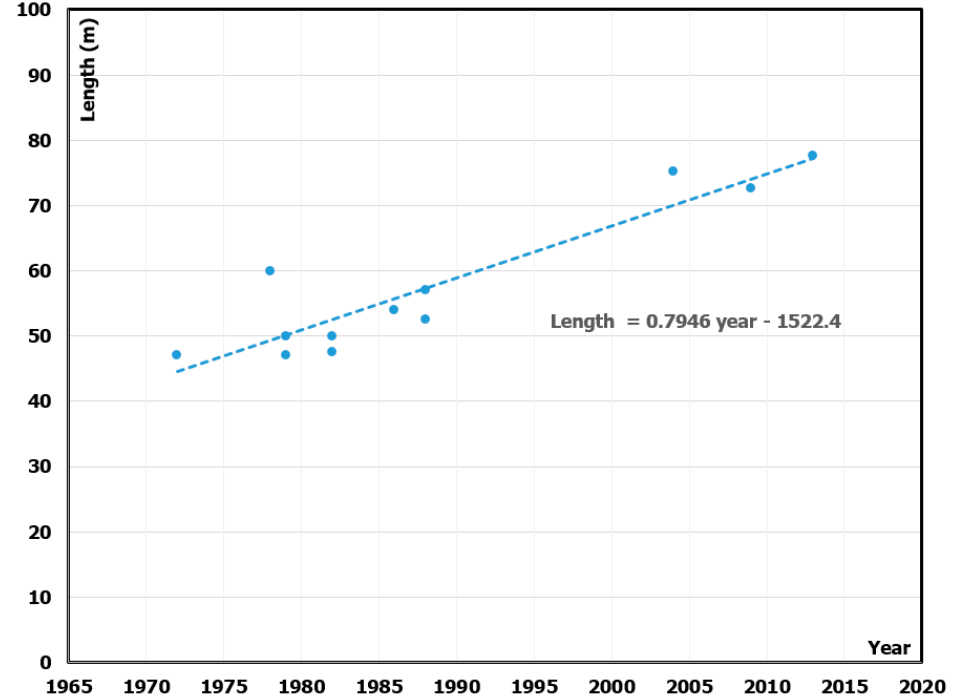
Figure 3. Projection of ship length against first in class launch date for key vessels.